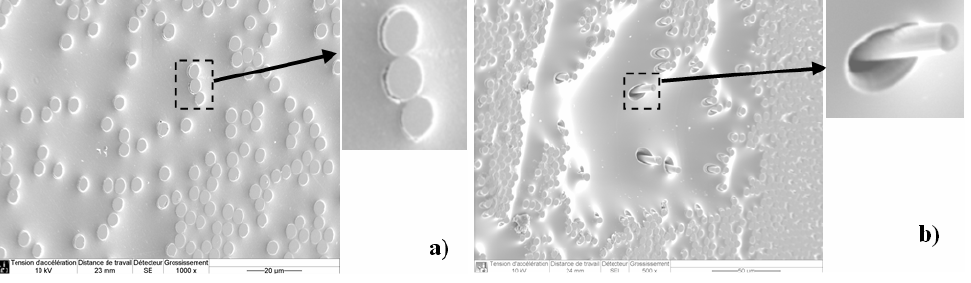
Fig. 8. SEM observations (45° tilted) of the sample aged isothermally at 150°C under 5 bars oxygen (a) 20h and (b)